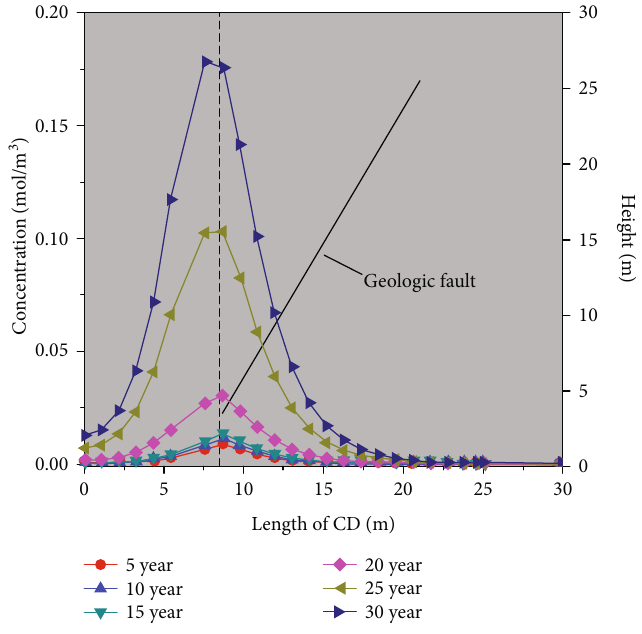
Figure 7: The contaminant concentration along the line of CD in the MF